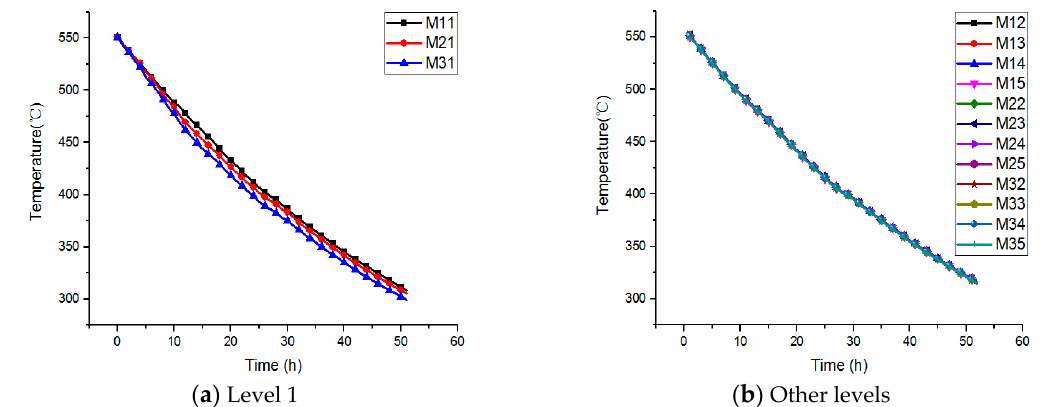
Figure 7. The temperature distribution of molten salt at 550~310 °C at various levels.